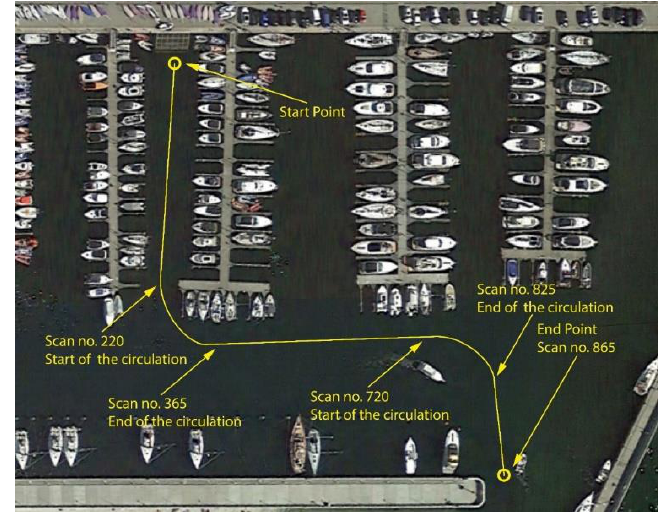
Figure 9. The trajectory covered by the USV at the time of measurements.